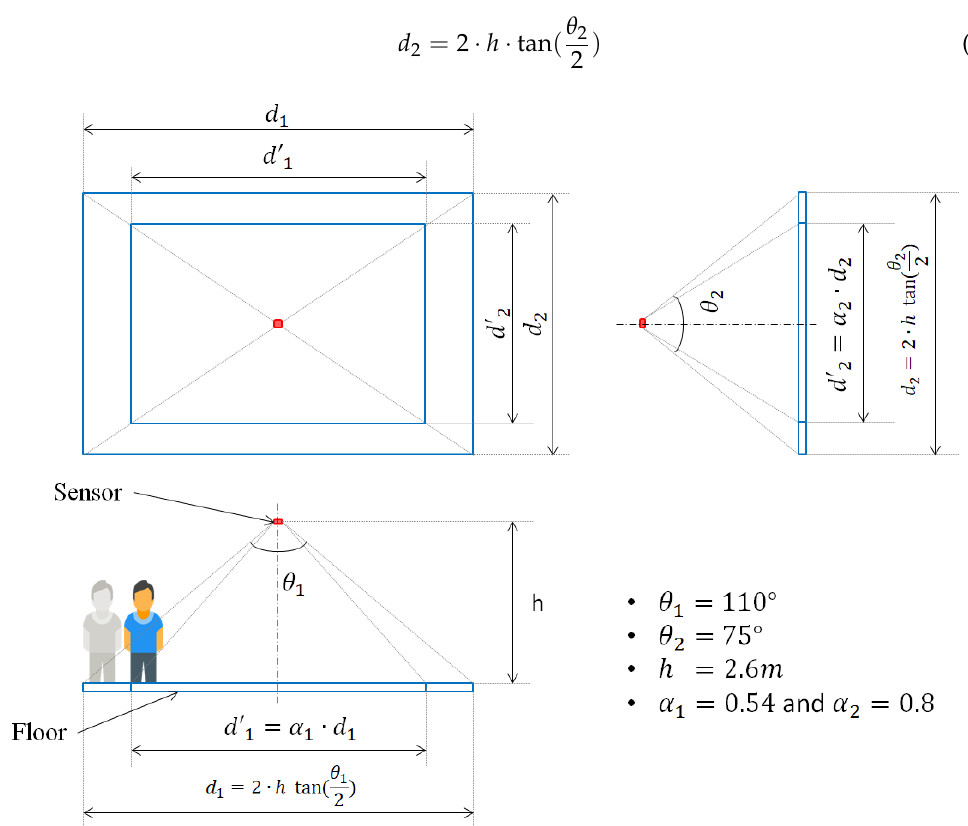
Figure 3. The dimensions of the area covered by the